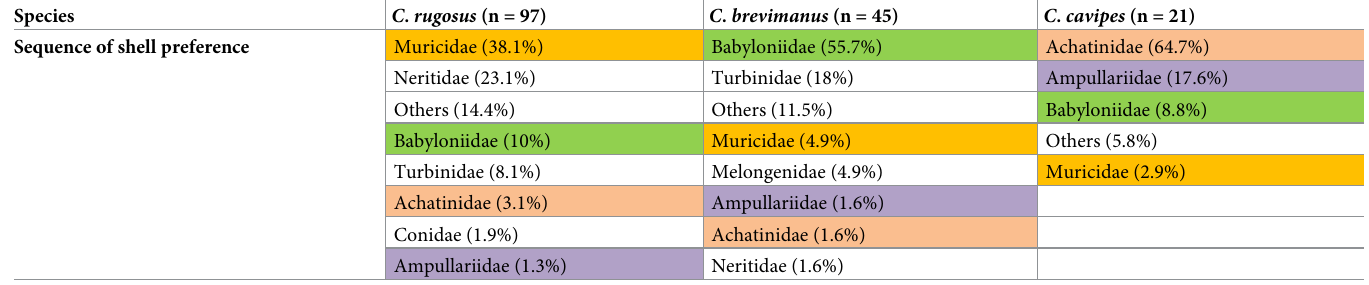
Table 3. Differences in families of shells preferred by the three species in the overlapping body size range of 0.7–1.3 cm shield length. Entries are ordered according to highest percentage for each species. The same color represents the same family of